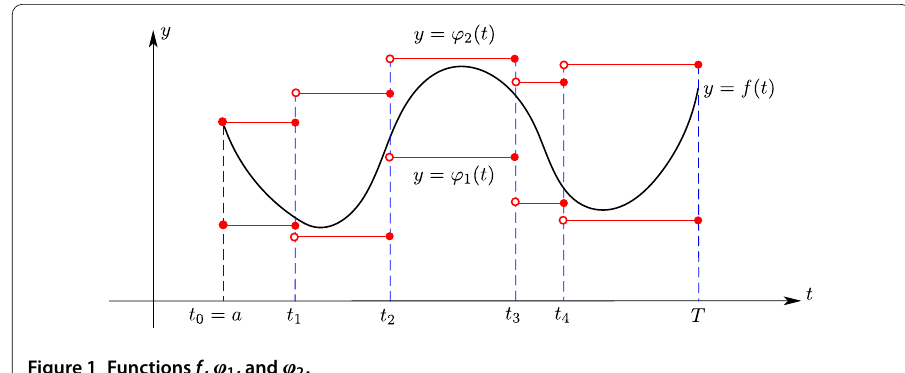
Figure 1 Functions f , ϕ 1 , and ϕ 2